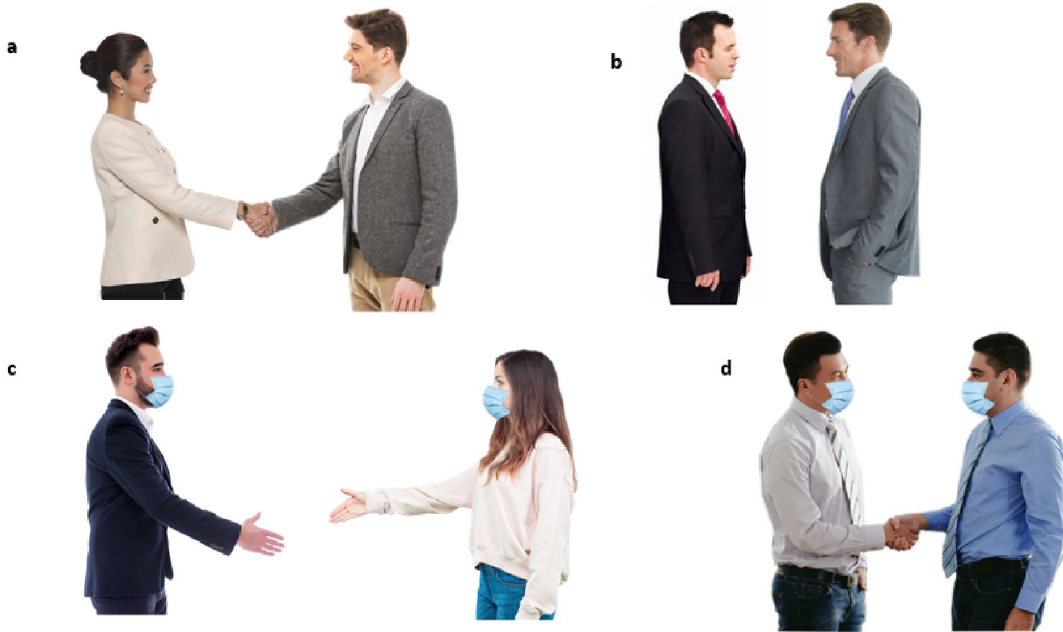
Figure 1. Sample stimuli. Panel ( a ) female-male, 90 cm, interaction, no mask. Panel ( b ) male-male, 50 cm, no interaction, no mask; Panel ( c ) male–female, 150 cm, interaction, mask. Panel ( d ) male-male, 50 cm, interaction,